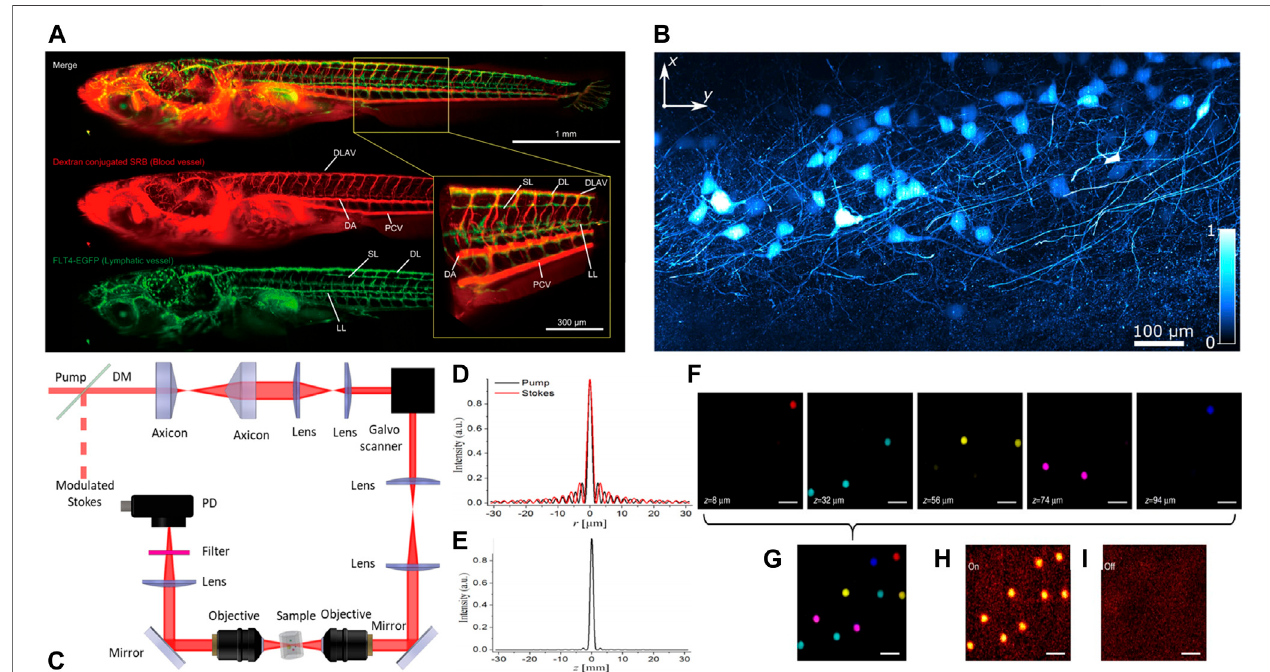
FIGURE12|(A) EntirebodyimagingofMedakalarvaeusingthedual-colorLSFM.3Dreconstructed viewofthelymphaticandblood vesselsintheentirebodyina 2 wphlarva.GreenrepresentstheEGFPsignalsfromtheFLT4-EGFPtransgenicstrain,andreddemonstratesthedextran-conjugatedrhodaminesignalsfromtheblood vessel. Yellow rectangular illustrates a magni fi ed view at the body trunk [136]. (B) Maximum intensity projection of Thy-1 GFP-expressing mouse brain tissue, using the two-photon planar Airy light-sheet [127]. (C) The experimental setup for the stimulated Raman projection (SRP) microscopy. (D) Linear pro fi les of the pump and Stokes beams, (E) the SRP signal produced by the ring-overlapping Bessel beams, (F) the SRS imaging of polystyrene beads located at different depths by Gaussian beams SRS microscopy, and (G) the volumetric image by SRP microscopy with Raman resonance (H) on and (I) off. Reprinted with permission of OSA [127]. Reproduced from Springer Nature [26,